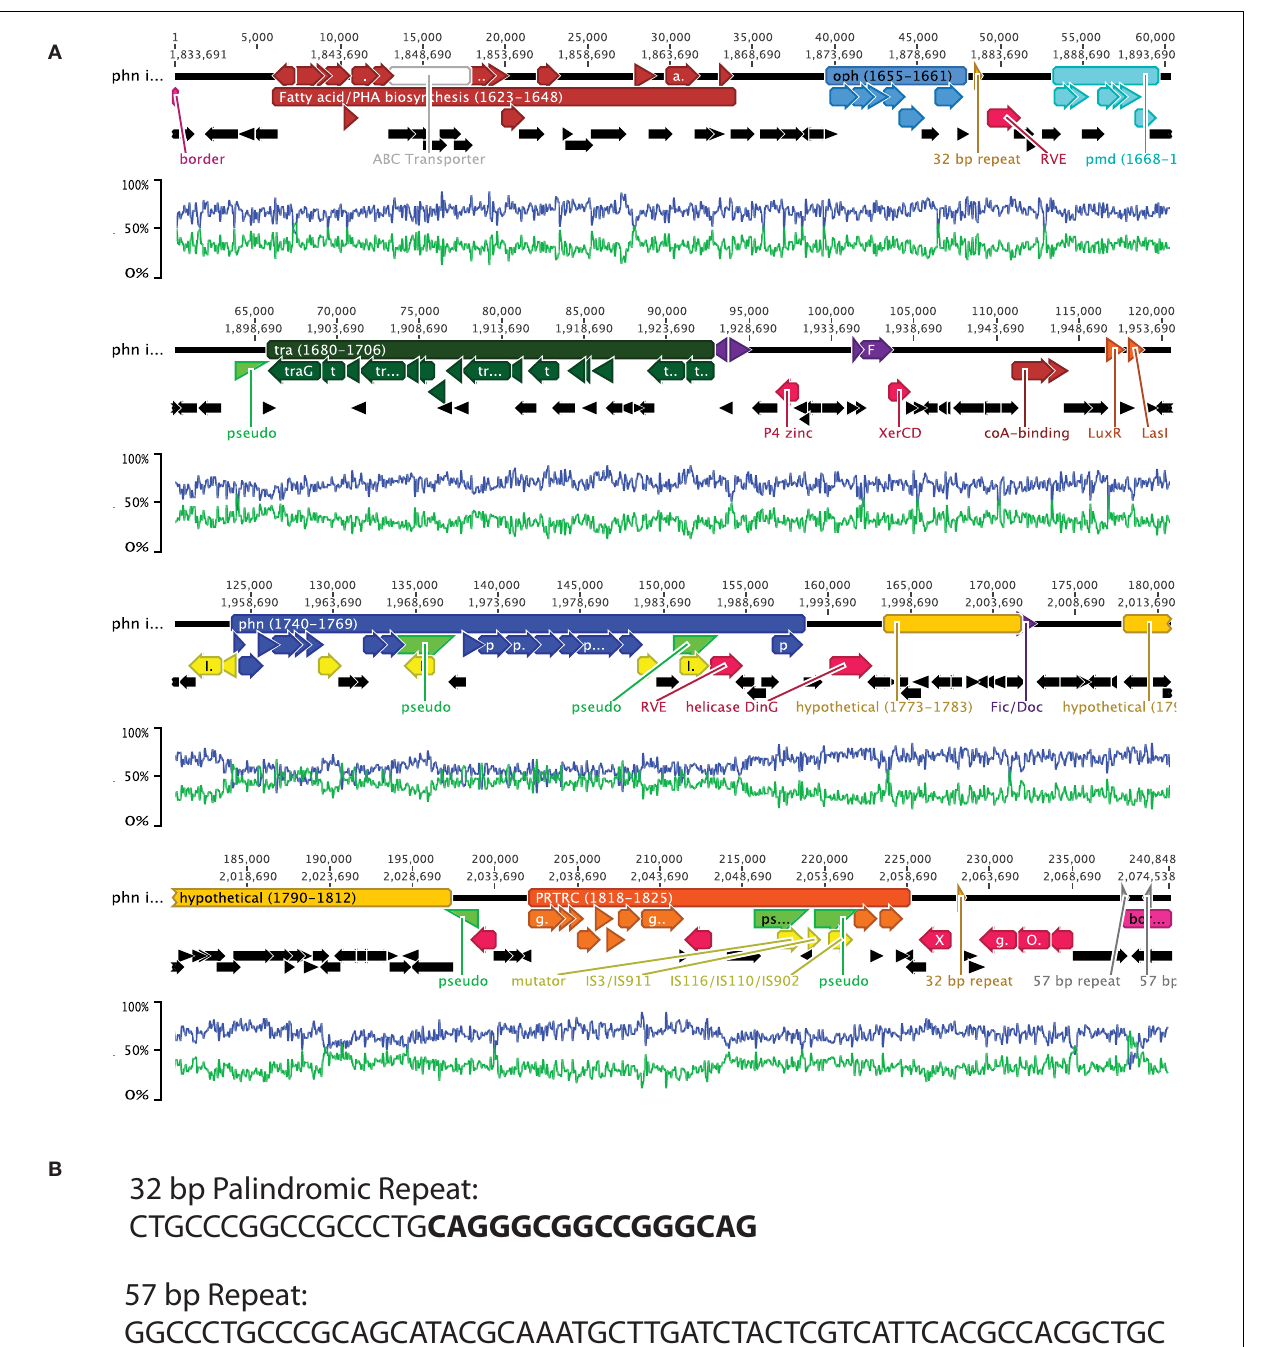
regulation/stabilization (purple), transposons (yellow), pseudogenes (bright green half arrows), and other genes including hypothetical (black). Additional genes and features discussed in the text are colored and labeled. Lines beneath the gene diagram indicate the average%G + C (blue) and average%A + T (green) of the overlaying region. (B) Sequences of the 32-bp palindromic and 57-bp repeats indicated in (A) and discussed in the text.The two halves of the palindrome are distinguished by normal vs. boldface